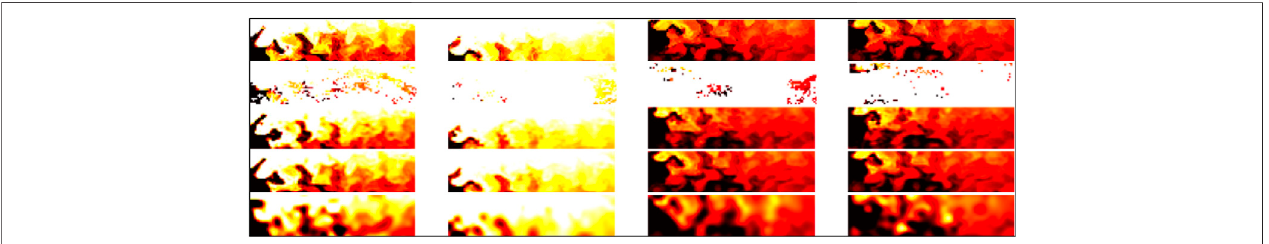
FIGURE 6 | Interpolation examples for SST data never seen during training: the fi rst row, reference SST images corresponding to the center of the considered 11 day time window; the second row, associated SST observations with missing data; the third row, interpolation issued from the FP(15)-GENN 2 model; and the last row, reconstruction ofthegap-freeimageseriesissuedfrom theFP(15)-GENN 2 model; interpolationissuedfrom anOIscheme usingaGaussiancovariance model with empirically tuned parameters.